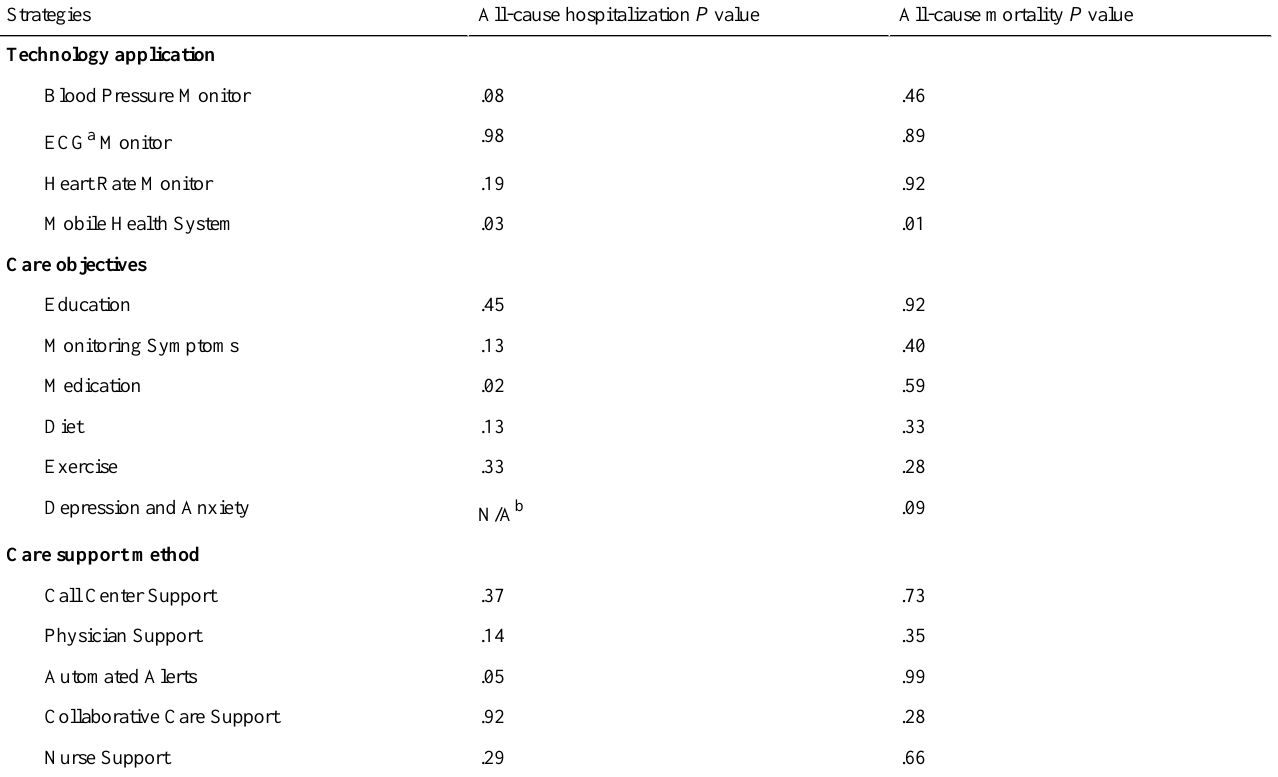
Table 6. Comparison of the effect of telemonitoring strategies on all-cause hospitalization and all-cause mortality between subgroup 1 and subgroup